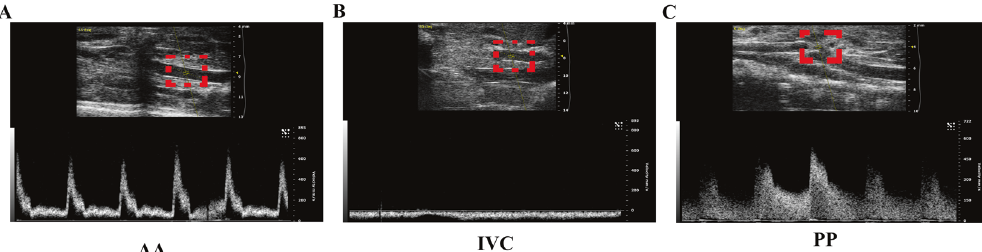
Fig. 1 Establishment of the abdominal aorta and inferior vena cava fi stula (AVF). A There was pulsatile blood fl ow in the abdominal aorta (AA), with a peak blood fl ow velocity of 600 mm/s. B The inferior vena cava (IVC) manifested no pulsatile blood fl ow. C Representative image of the pulsating blood fl ow at the puncture point, with a peak blood fl ow velocity of 580